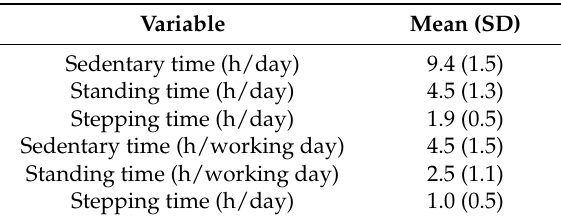
Table 2. Participant baseline data.